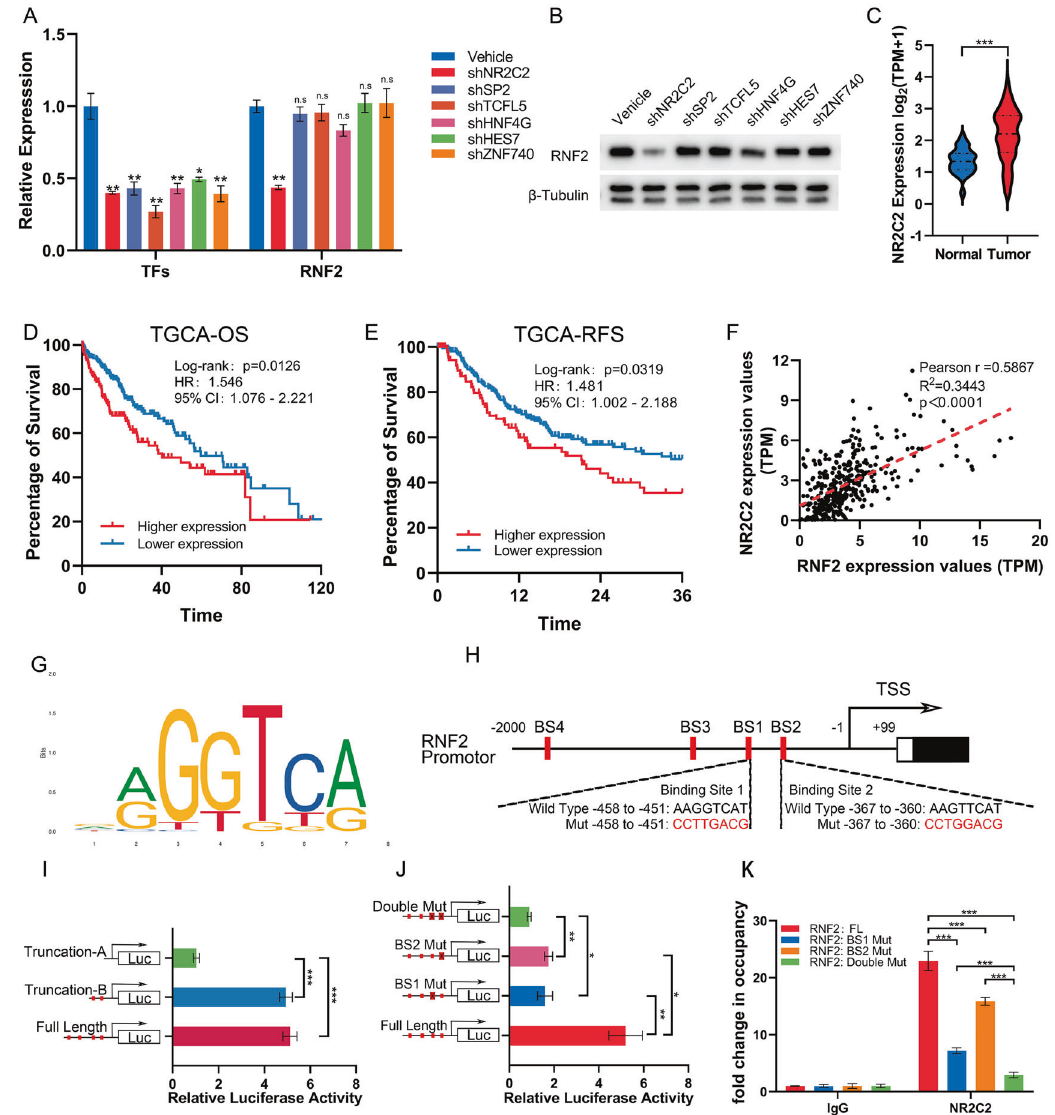
Fig. 2 NR2C2 increases RNF2 transcription in HCC. A , B Quantitative PCR results and WB results revealed that only knockdown of NR2C2 down regulated the expression of RNF2, not the rest of TFs. C The expression level of NR2C2 in tumor and normal tissues was analyzed using TGCA-LIHC dataset. D , E Kaplan-Meier analysis showed that HCC patients with high NR2C2 expression in TGCA-LIHC dataset were signi fi cantly associated with lower OS and RFS. F Correlation analysis of TCGA-LIHC dataset showed that the expression of RNF2 was positively correlated with NR2C2. G The predicted NR2C2 binding motif found in the RNF2 promoter (JASPAR MA1536.1). H Possible binding sites of NR2C2 in RNF2 promoter region predicted by JASPAR database and the mutation strategy of BS1 and BS2. I Dual-luciferase reporter assay results of the full length and truncated RNF2 promoter sequence. J Dual luciferase reporter assay results of single mutation or double mutation of BS1 and BS2. K Chromatin immunoprecipitation (ChIP) was performed on 293 T cells transfected with different RNF2 promoter sequence vectors using anti-NR2C2 antibody,